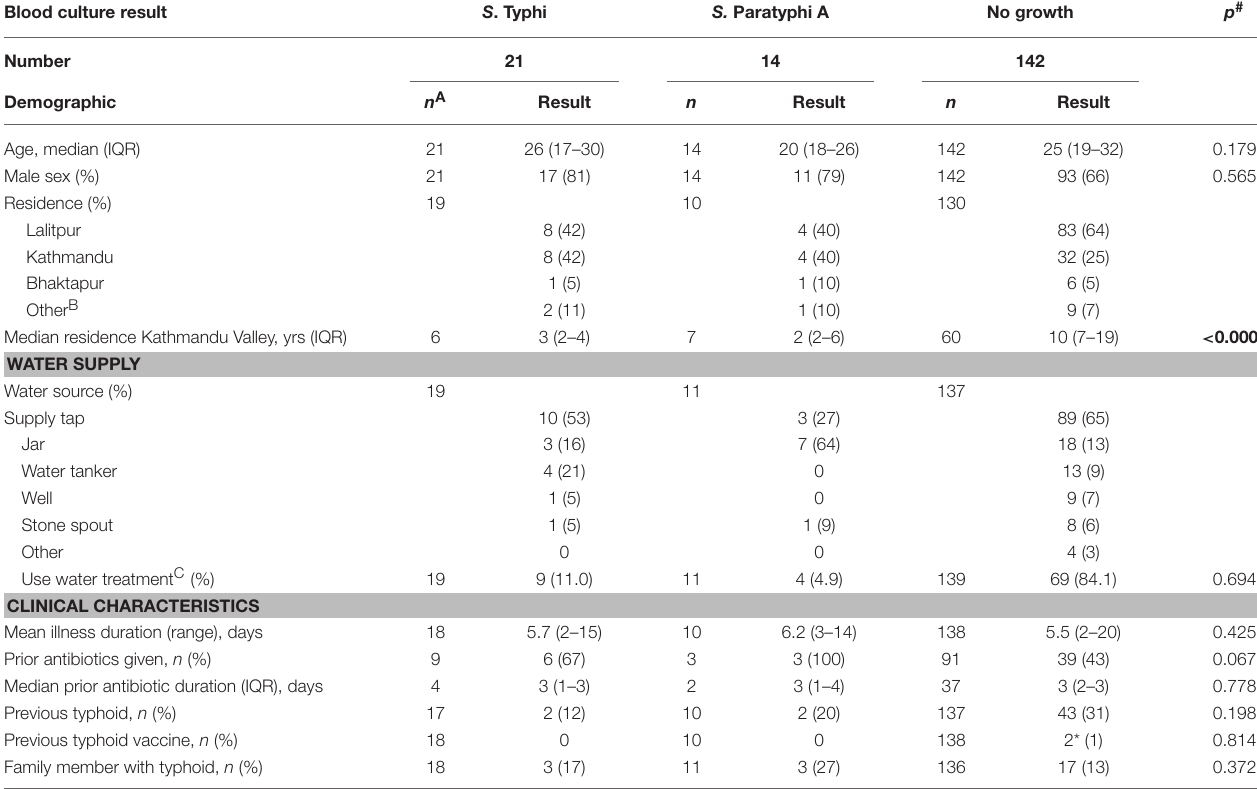
TABLE 5 | Nepal ALS study participant demographics and clinical characteristics. Blood culture